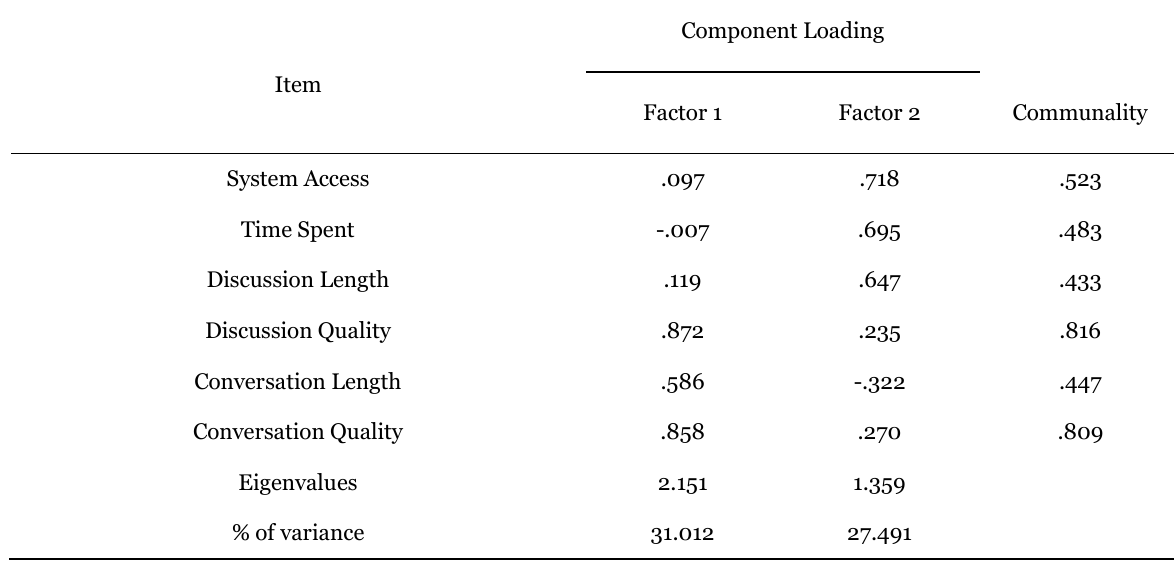
Component Loadings for the Rotated Components (N =